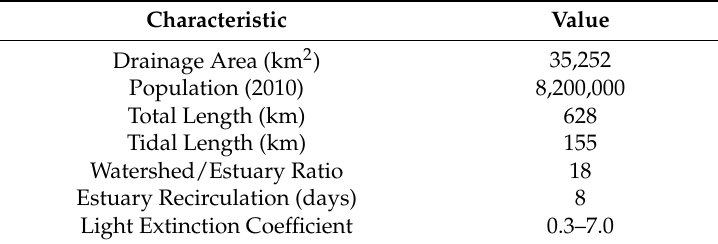
Table 1. Characteristics of the Delaware River [17,25].